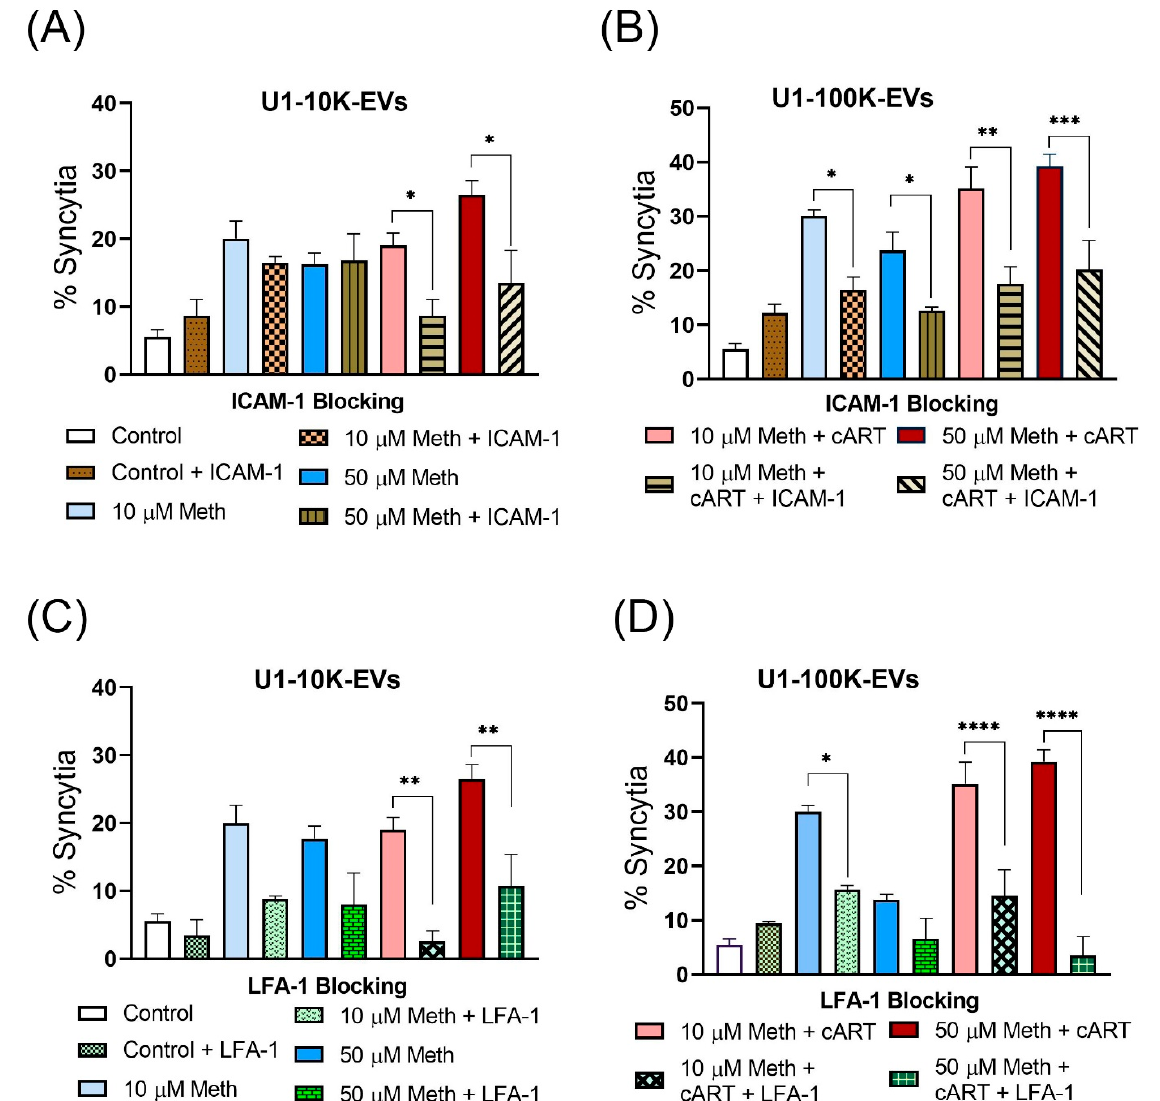
Figure 6. Blocking of syncytia formation by treating EVs with ICAM-1 Ab and MDMs with LFA-1 Ab for 24 h. % of syncytia formation in the different groups after overnight ICAM-1 Ab treatment of U1 10 K EV sets ( A ) and U1 100 K EV sets ( B ) and after 3 h incubation of these treated EVs on naïve MDMs. % of syncytia formation in the different groups after overnight MDMs treatment with LFA-1 Ab and on these MDMs 3 h incubations of U1 10 K ( C ), and 100 K ( D ) EV sets. N= 3 (MDMs from three different biological donors); cell: EV cell ratios = 1:10,000; data are shown as mean +/ − SEM and represent at least three independent assays done in triplicate. * p < 0.05; ** p < 0.01; *** p < 0.001, **** p < 0.0001.